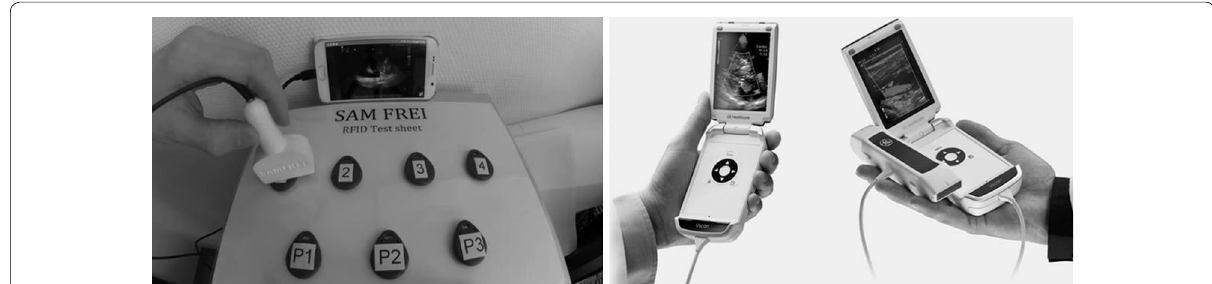
P2, and P3 which allow for different findings to be displayed with the same tag 1 , 2 , 3 , or 4 ,